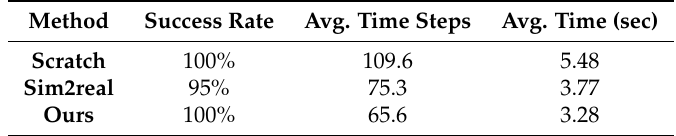
Figure 7. Performance of learned policy (sim2real + retrain) on 3D-printed cuboid-peg-insertion task. Insertion direction was aligned with the y axis of the robot’s coordinate system. Relative distance from the robot’s end effector to goal position and contact force are shown. The 24 policy actions besides the corresponding axis are also shown. Table 2. Comparison of learning from scratch, straightforward sim2real, and sim2real + retraining (ours). Test performed on a 3D printed cuboid peg insertion task assuming knowledge of the true goal